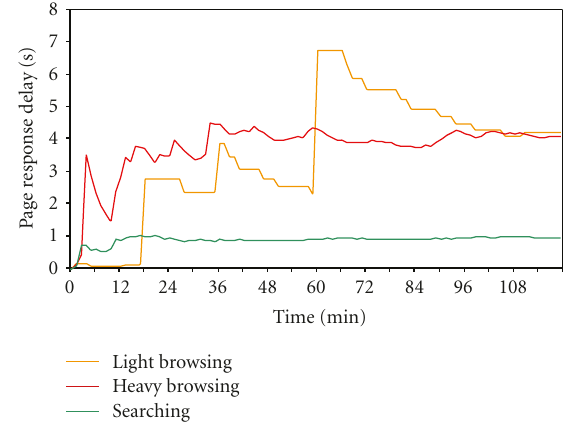
Figure 12: Average Web page delivery